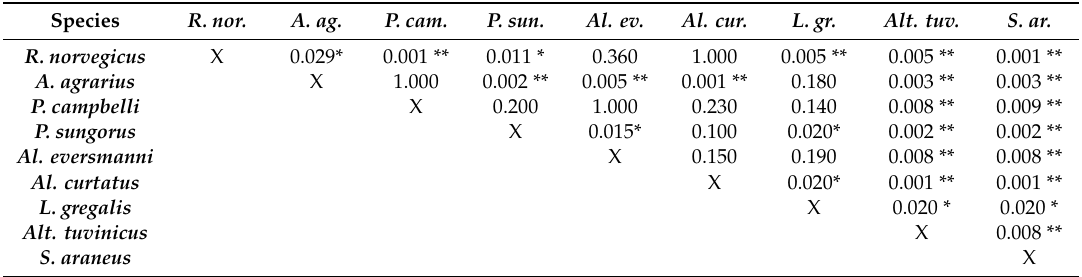
Table 7. The volumes of Fisher’s exact criterion (** p < 0.01, * p < 0.05). Species R.